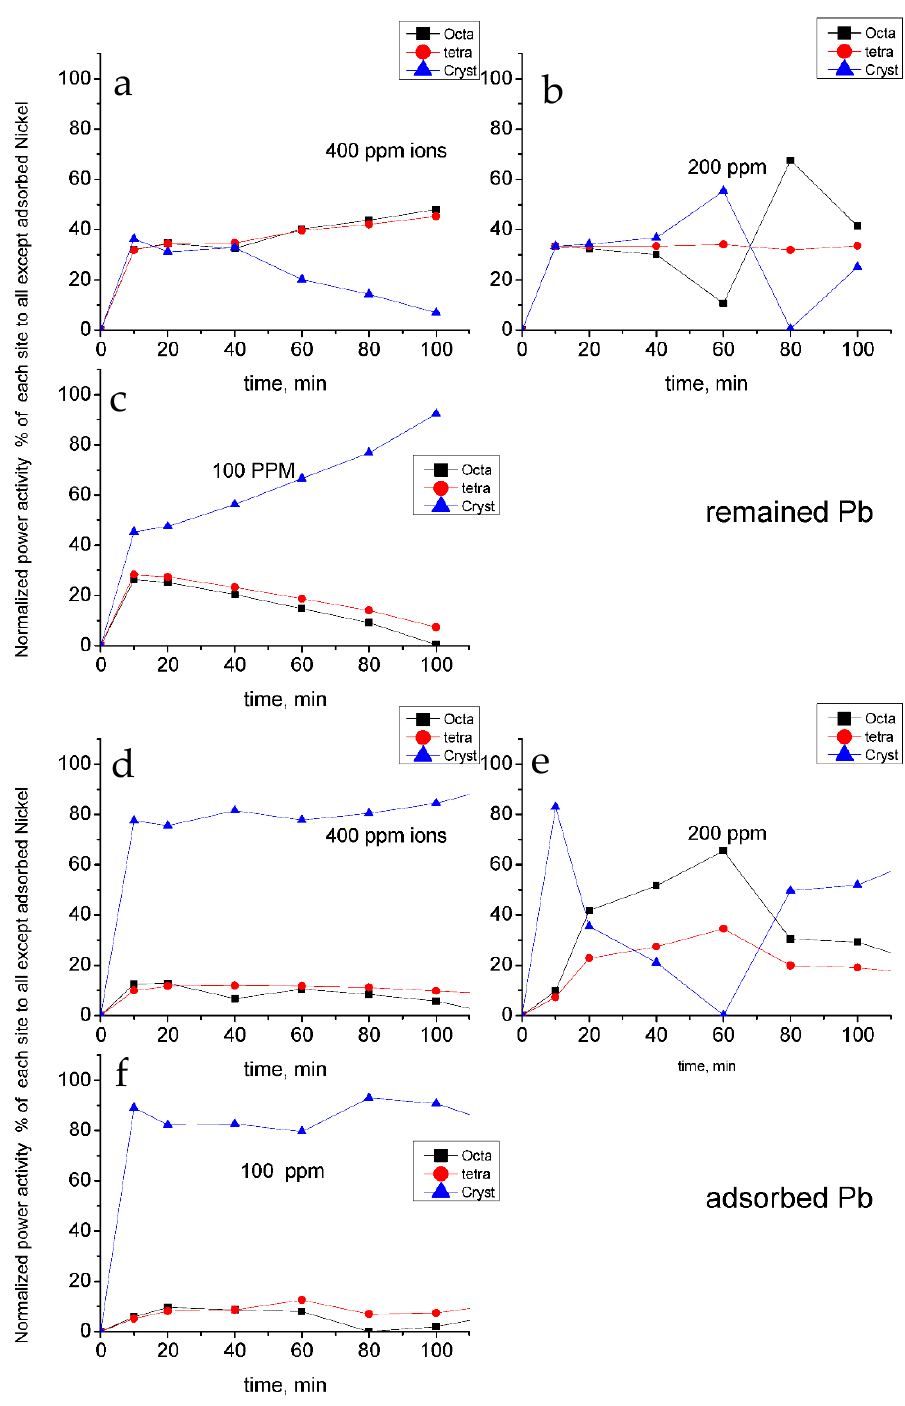
Figure 16. Effect of remained and adsorbed lead ions on the power activity map: ( a ) 400 ppm remained; ( b ) 200 ppm remained; ( c ) 100 ppm remained; ( d ) 400 ppm adsorbed; ( e ) 200 ppm adsorbed; ( f ) 100 ppm adsorbed.